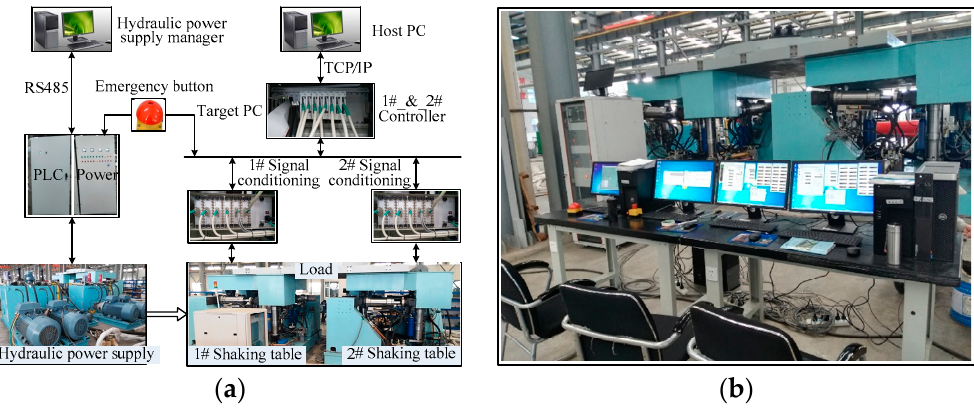
Figure 13. The dual ‐ shaking table experiment system. ( a ) Real ‐ time control system; ( b ) Built Figure 13. The dual-shaking table experiment system. ( a ) Real-time control system; ( b ) Built experiment system. experiment